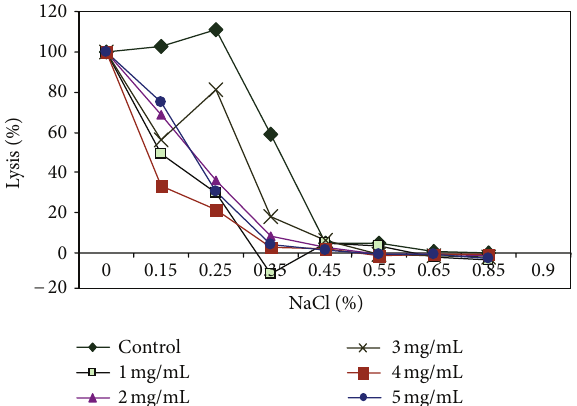
Figure4:Osmoticfragiliogramsaftersupplementationwithvarious concentrations of Fagara root extract.